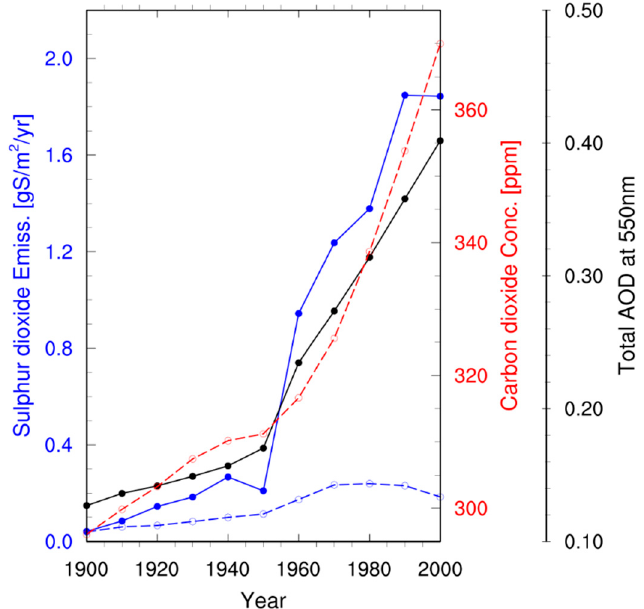
Figure 2. The time variation of the historical emissions of anthropogenic sulphur dioxide and carbon dioxide from 1900 to 2000 based on the RCP database v2.0.5 [51] and the simulated aerosol optical depth from CMIP5 models. The global sulphur dioxide emission (blue dashed line with open circle), the Asian emissions (blue solid line with closed circle) are shown; the black line indicate the total aerosol optical depth at 550 nm in JJA over East Asia.